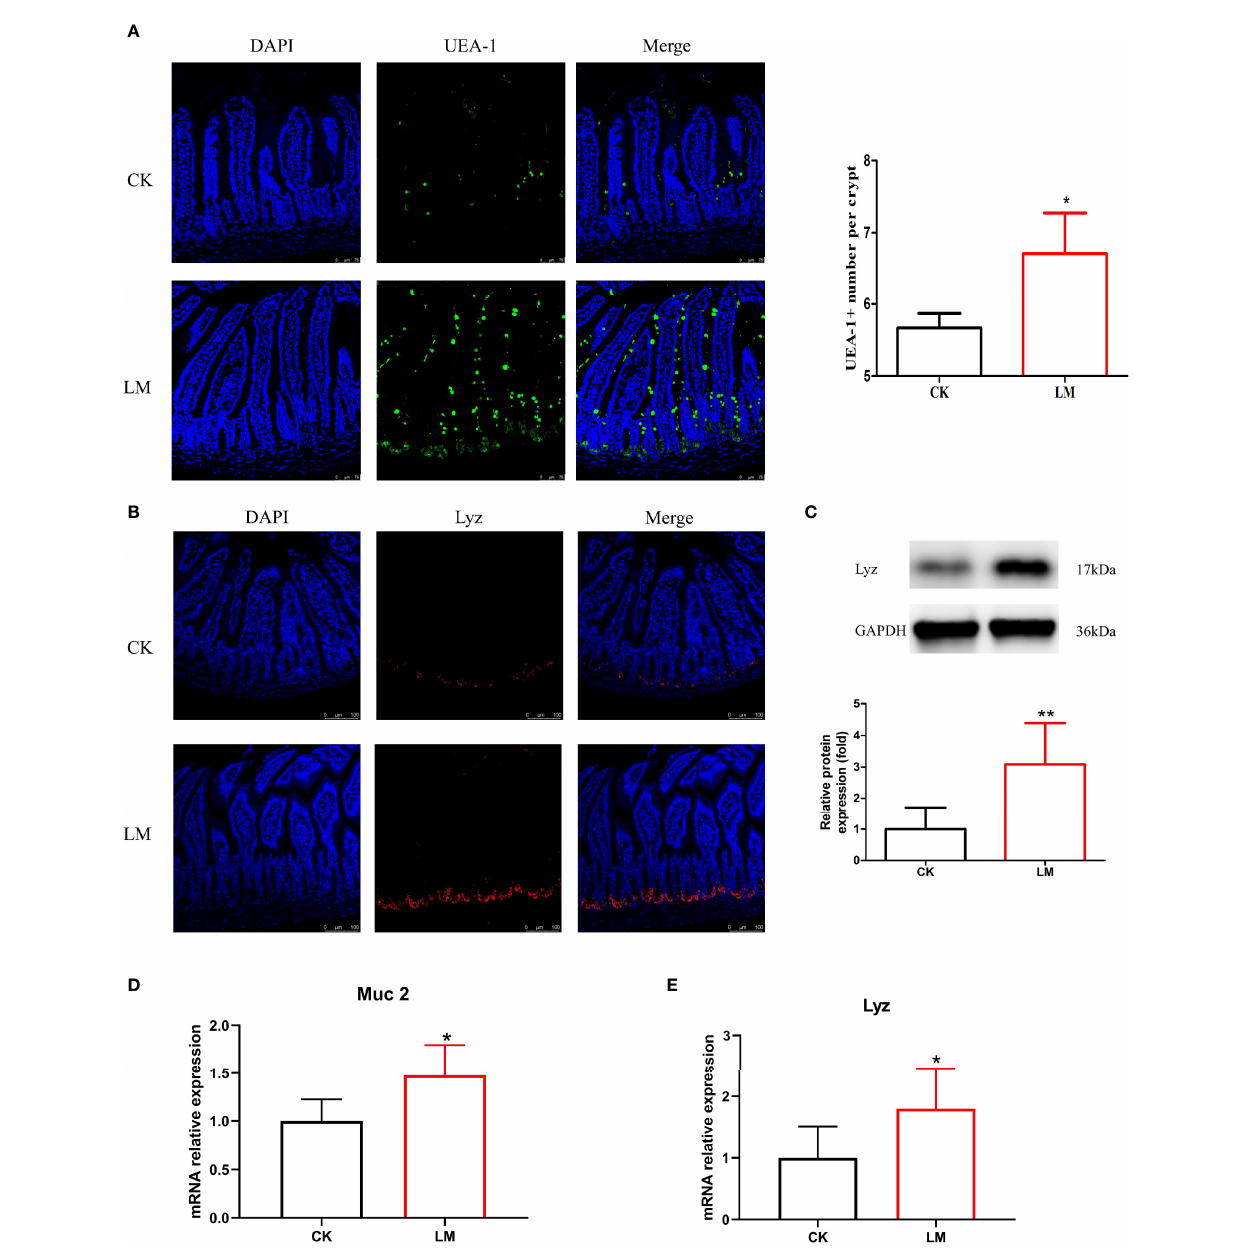
FIGURE 2 | The in fl uence of L. monocytogenes on the differentiation of intestinal secretory cells in mice. CK, control, orally challenge with PBS; LM, L. monocytogenes -infected group. (A) Confocal microscopy analysis of mucus stained with UEA-1 in jejunum sections. (B) Confocal microscopy analysis of lysozyme in jejunum sections. (C) Western blot of lysozyme in jejunum. (D) mRNA levels of Muc2 from homogenized jejunum samples. (E) mRNA levels of Lyz from homogenized jejunum samples. Data is presented as mean ± SD. * P < 0.05, ** P < 0.01. Data combined from at least three independent experiments unless otherwise